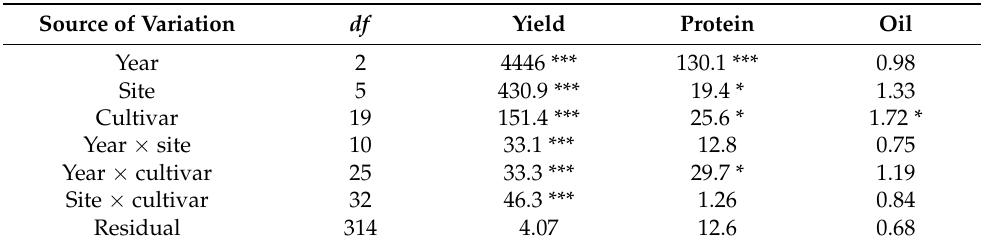
Table 6. Mean squares from the three-way analysis of variance for the seed yield, protein content and oil content of soybean. Source of Variation df Yield Protein Oil Year 2 4446